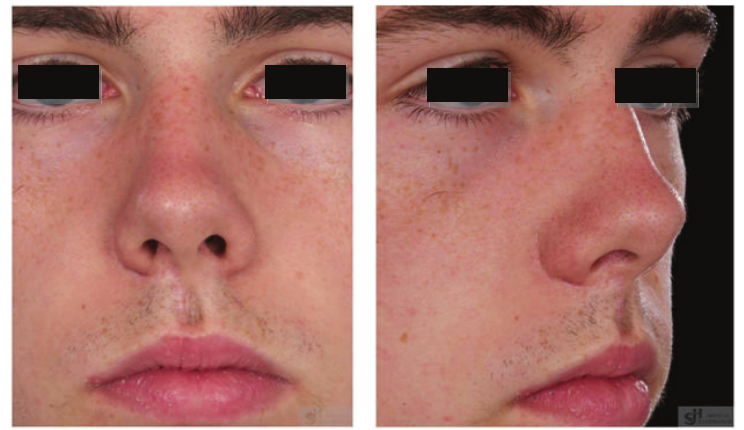
Figure 4: Postoperative photo demonstrating satisfactory appearance of extraoral